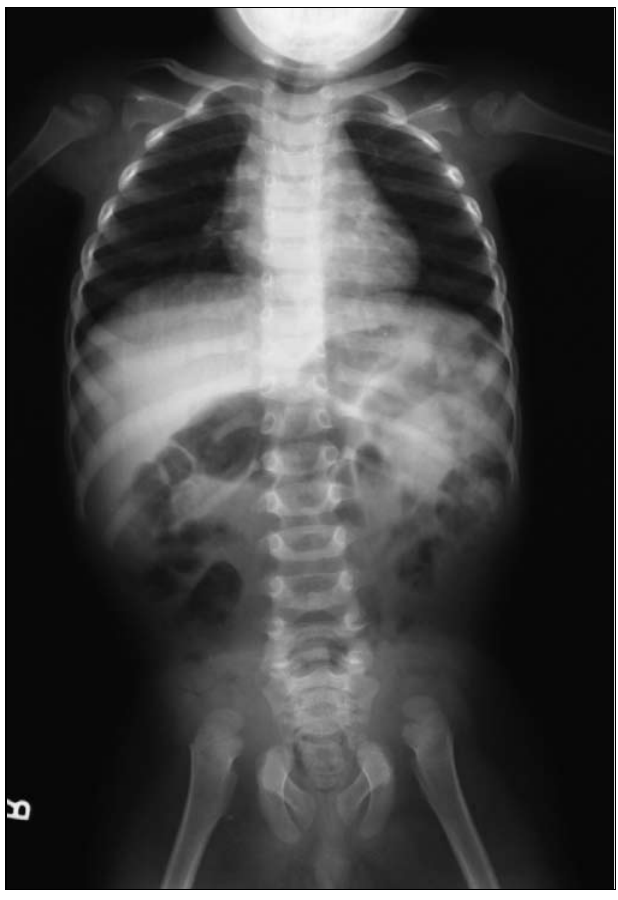
Fig. 1. Frontal radiograph of chest and abdomen shows bilateral absence of ilium and severe hypoplasia of the body of scapulae. The coracoid and acromion are normal bilaterally.